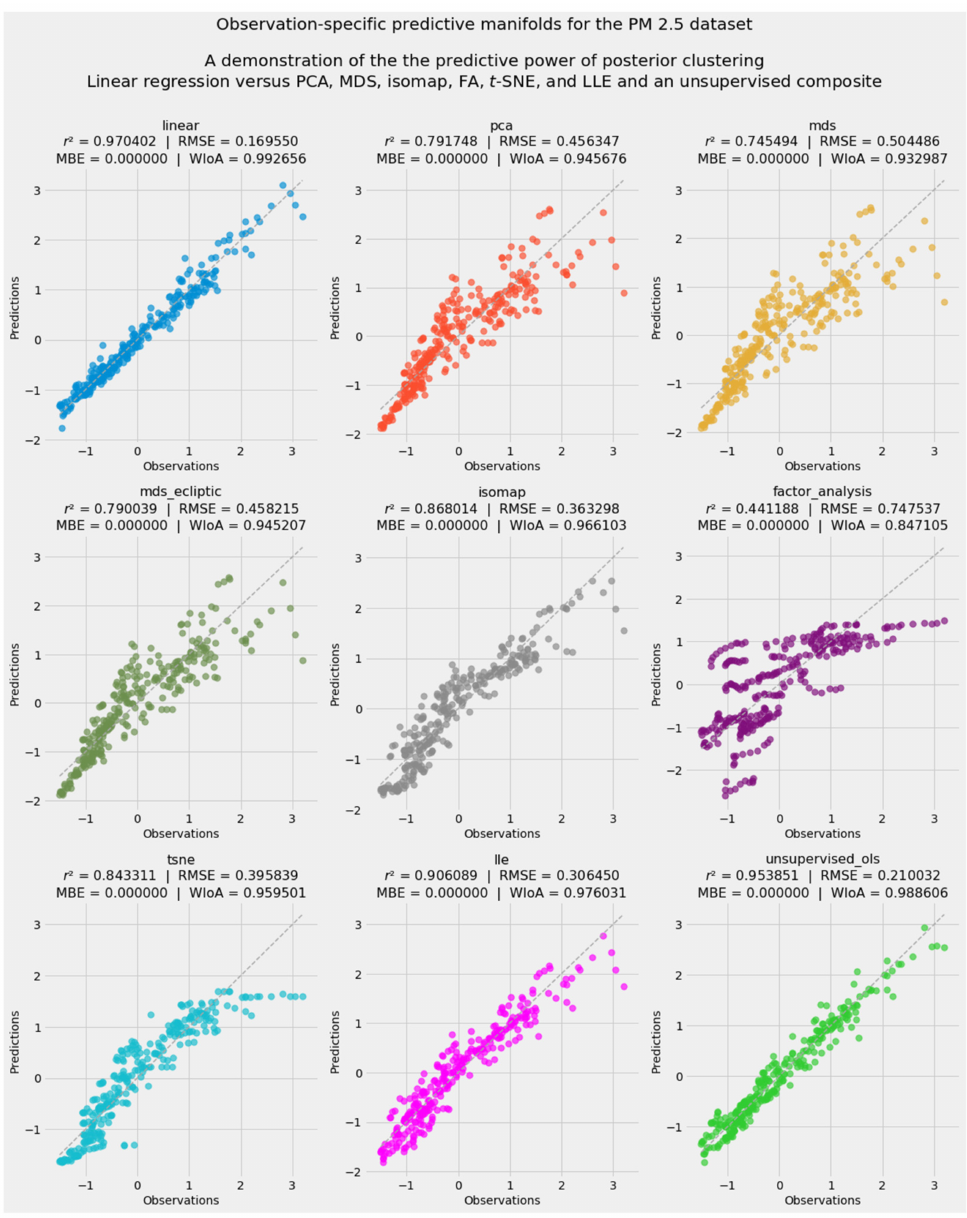
Figure 12. Predictive manifolds: a predictive application of unsupervised machine